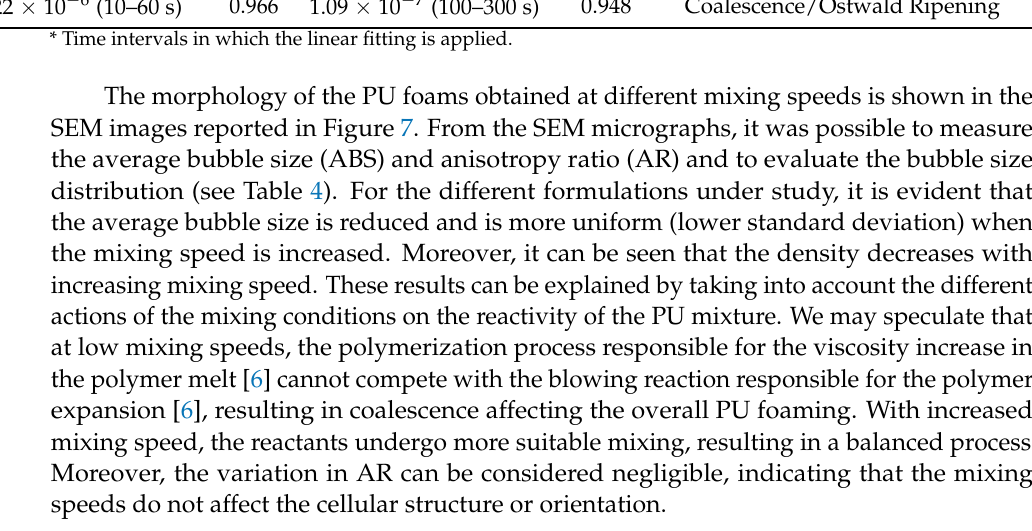
Figure 6. Bubble size evolution of the PU foams obtained at different mixing speeds. Table 3. Results of the fitting procedure caused by Equation (3).